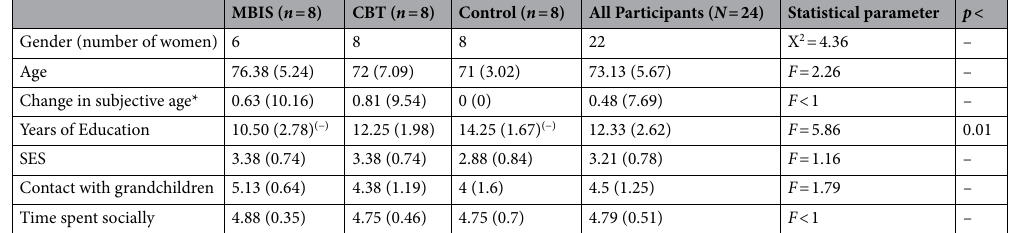
Table 1. Means ( SD s) and differences between groups in demographic variables. (−/ +) Reflect significant differences between the groups in follow-up analyses. *Subjective age refers to participants’ responses about how old they feel; the discrepancy between chronological age and subjective age is recorded in years (for more details, see 38 ).